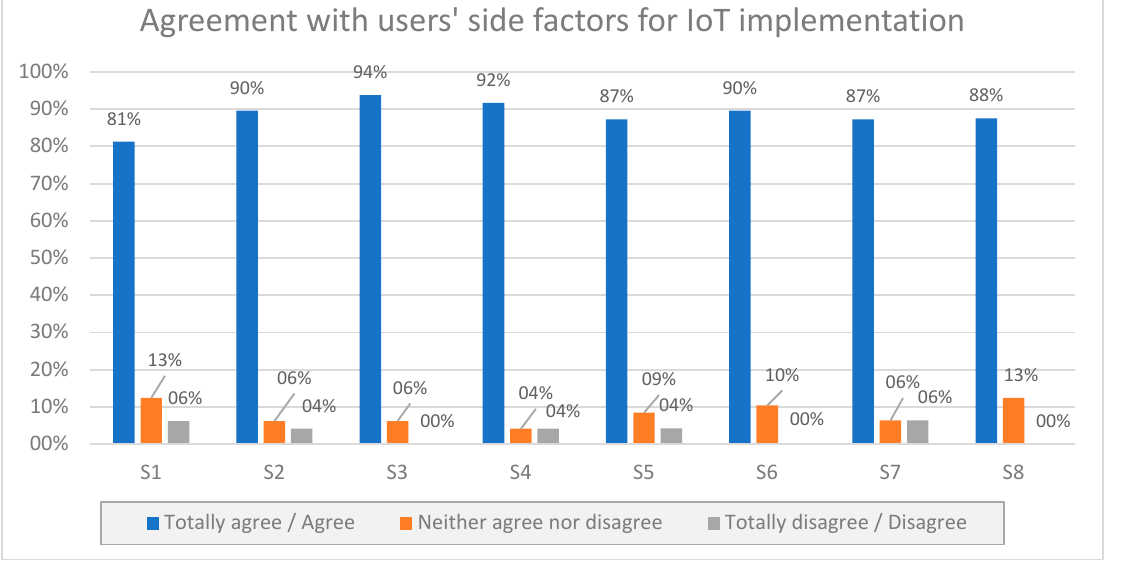
Figure 1. Summary of agreement of users with statements on impact factors for IoT success. The free space left for comments in the survey only attracted three comments without relevance to the analysis.